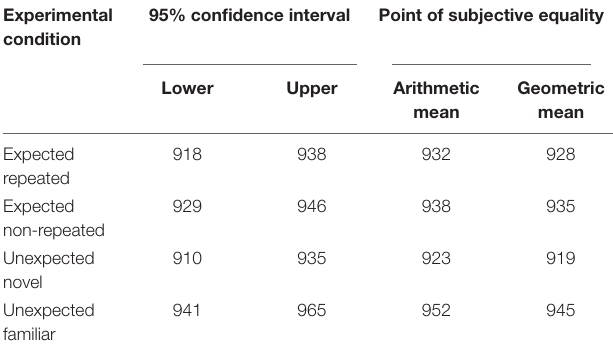
TABLE 2 | 95% confidence intervals for the point of subjective equality of duration (ms) in each experimental condition and the respective arithmetic and geometric mean (Experiment